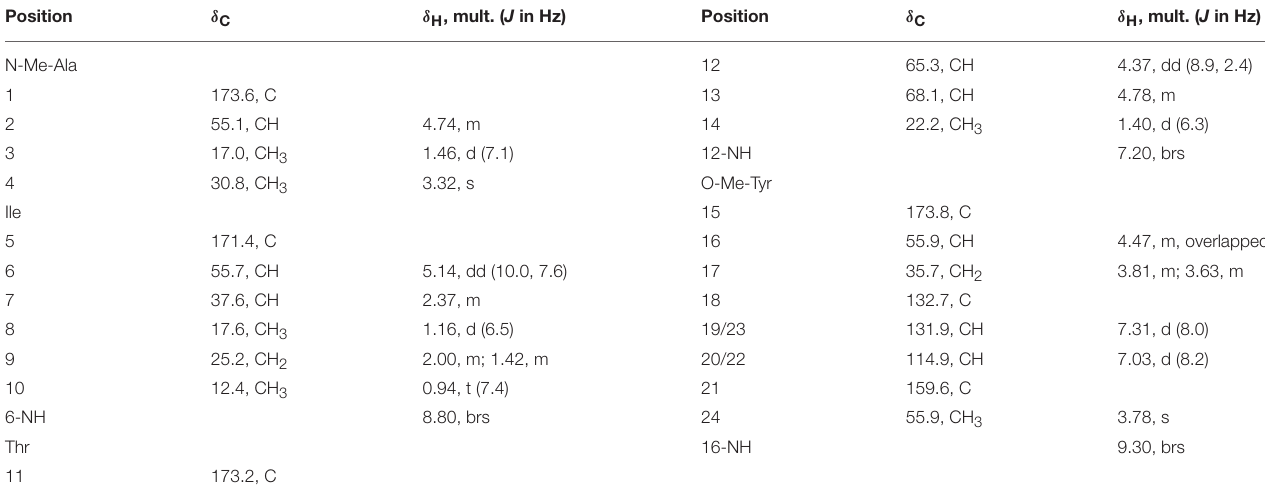
TABLE 1 | 1 H (600 MHz) and 13 C NMR (150 MHz) Data for 1 in Pyridine- d 5 .